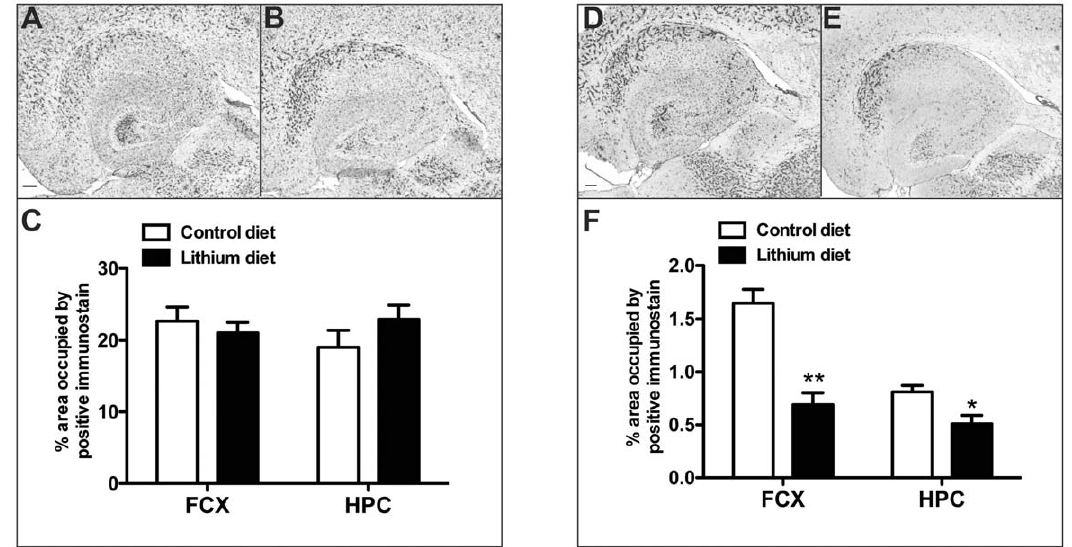
Figure 5. Microglial activation is reduced following lithium treatment. Panels A and B show CD11b immunocytochemistry in the hippocampus of APPSwDI/NOS2 2 / 2 mice receiving either control diet (A) or lithium diet (B) for 8 months. Scale bar in panel A for A and B=120 m m. Panel C shows quantification of the percent area occupied by positive stain for CD11b in the frontal cortex and hippocampus. Panels D and E show CD45 immunocytochemistry in the hippocampus of APPSwDI/NOS2 2 / 2 mice receiving either control diet (D) or lithium diet (E) for 8 months. Scale bar in panel D for D and E=120 m m. Panel F shows quantification of the percent area occupied by positive stain for CD45 in the frontal cortex and hippocampus. * indicates P , 0.05 and ** indicates P , 0.01 when compared to APSPwDI/NOS2 2 / 2 mice receiving control diet.